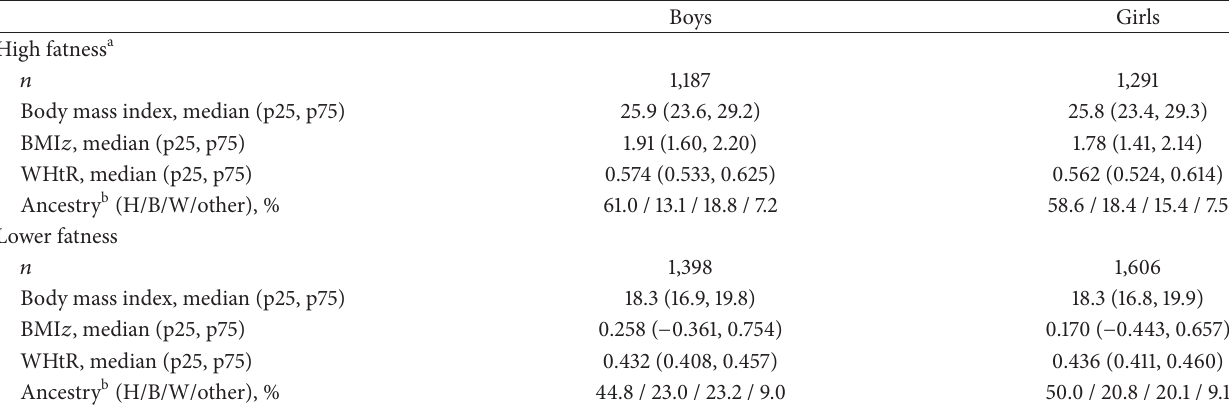
Table2:Distributionsofadiposityindicatorsandancestralgroups.Theanalyticsampleisdividedintofourmutuallyexclusivesubpopulations by sex and fatness level.